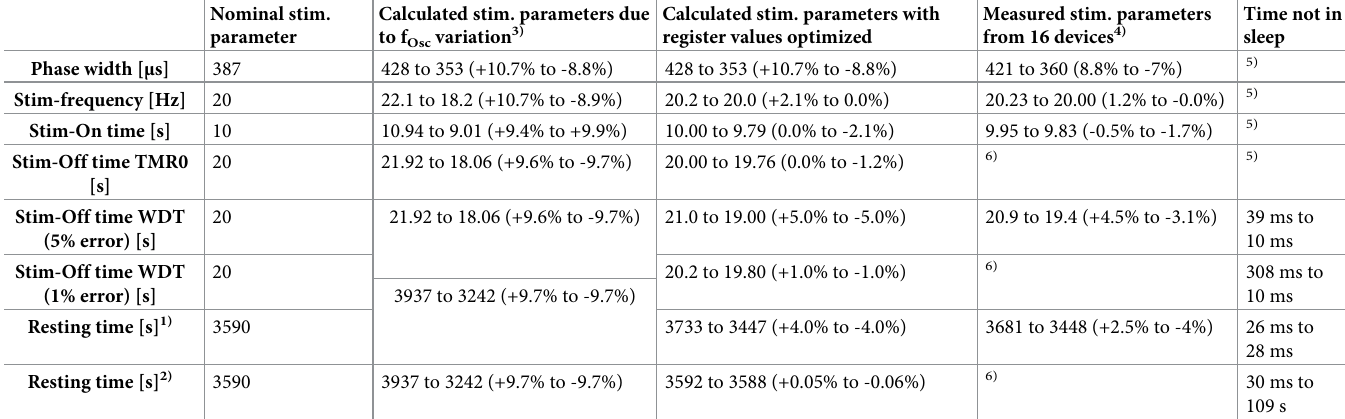
Measured stim. parameters from 16 devices